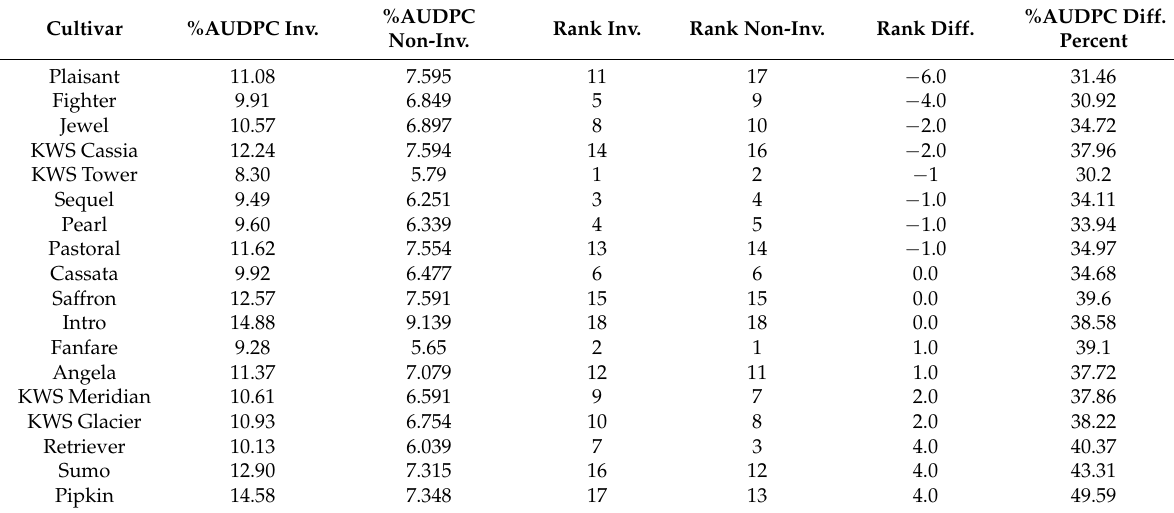
%AUDPC Diff. Percent